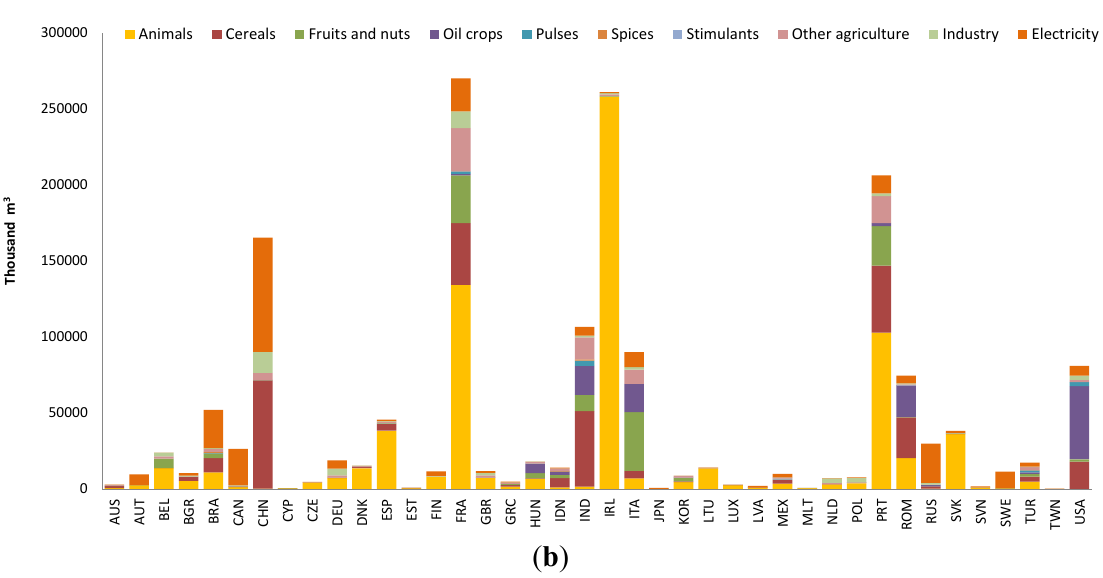
Figure 2. Blue virtual water imports of the food sector by country and sector in 1995 ( a ) and 2009 ( b ), thousand m 3